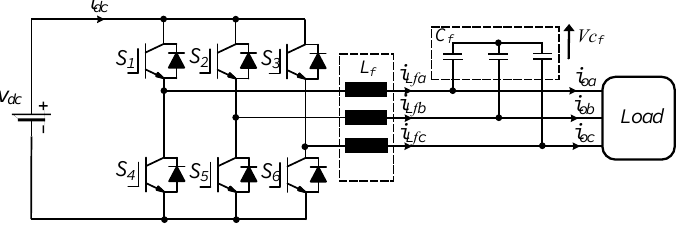
Figure 1. Power circuit schematic for a stand-alone voltage source converter